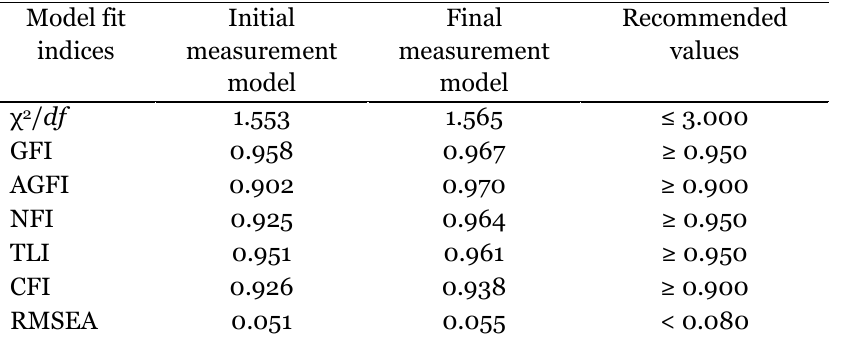
Measurement Model Fit Indices